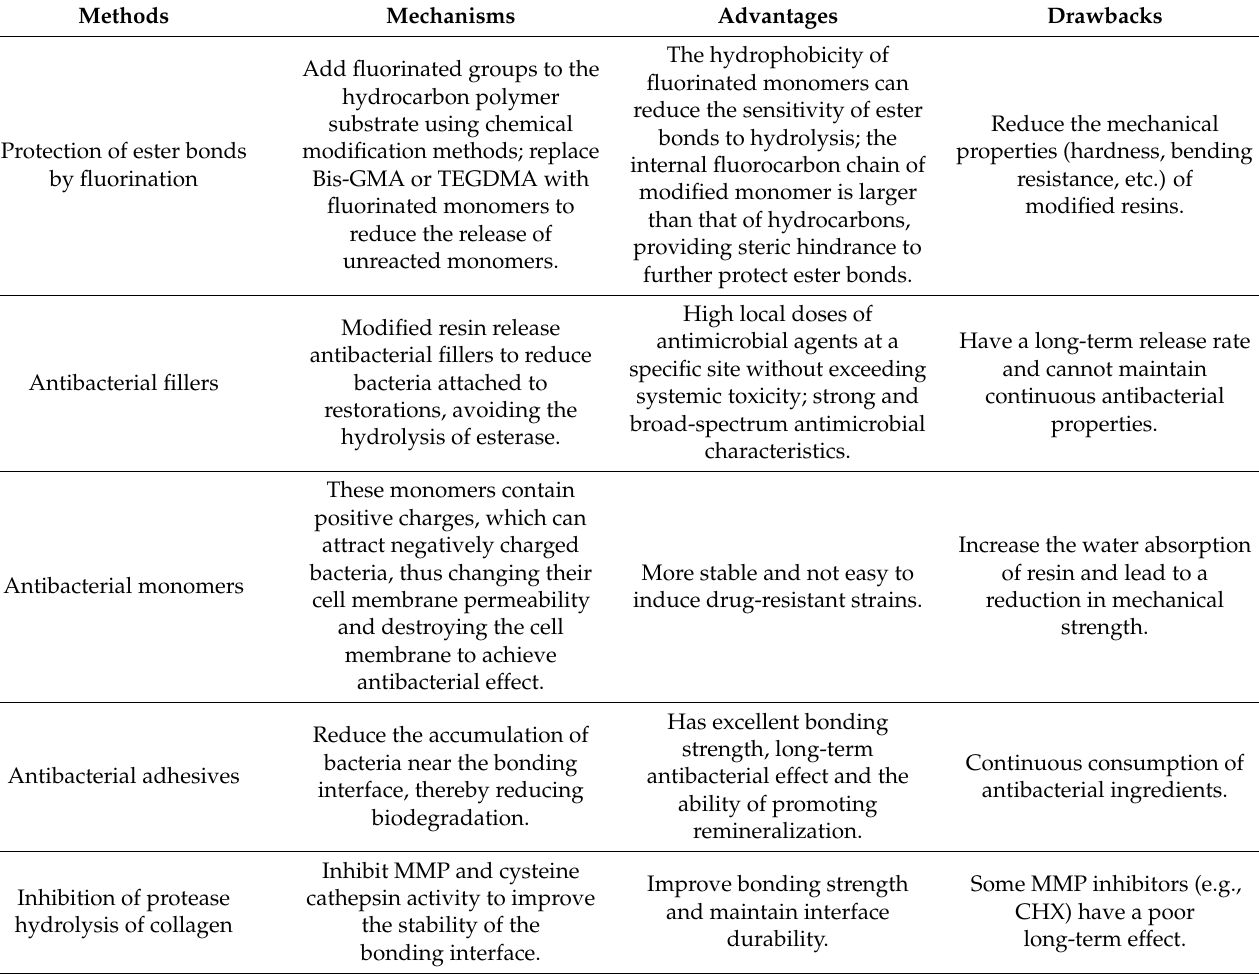
Table 1. Summary of the methods to reduce the occurrence of